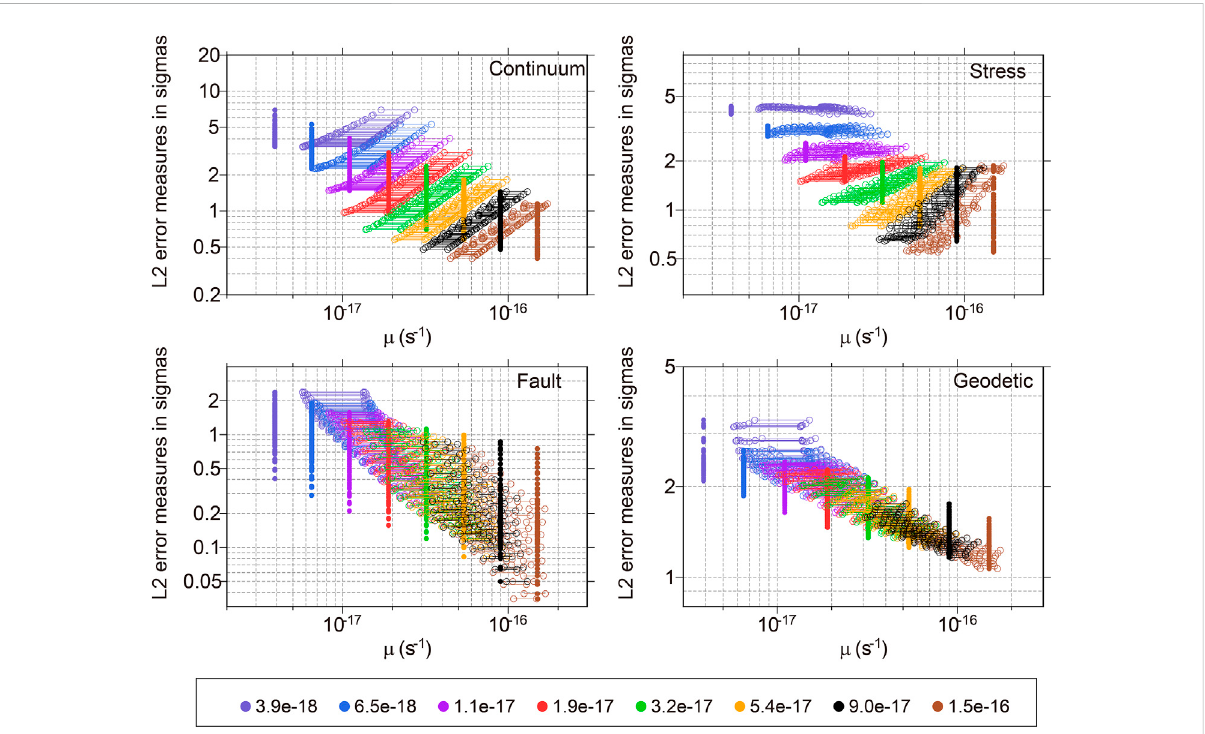
FIGURE 3 Different μ as a priori versus L2-norm errors (RMS prediction errors in units of standard deviations) of continuum-stiffness, stress direction, geological slip rate and geodetic velocity. (For each μ , L2 mis fi t errors of 64 models with various combinations of L 0 and A 0 are plotted as solid dots. ThemeanofabsolutecontinuumdeformationratesandtheirRMSassociatedwitheach μ versusL2mis fi terrorsofthesemodelsareplottedasopen circles, connected by horizontal lines. Different colors represent different μ and the associated continuum deformation rates. For self- consistency, μ should fall within the ranges between the mean of absolute continuum deformation rates and their RMS.).